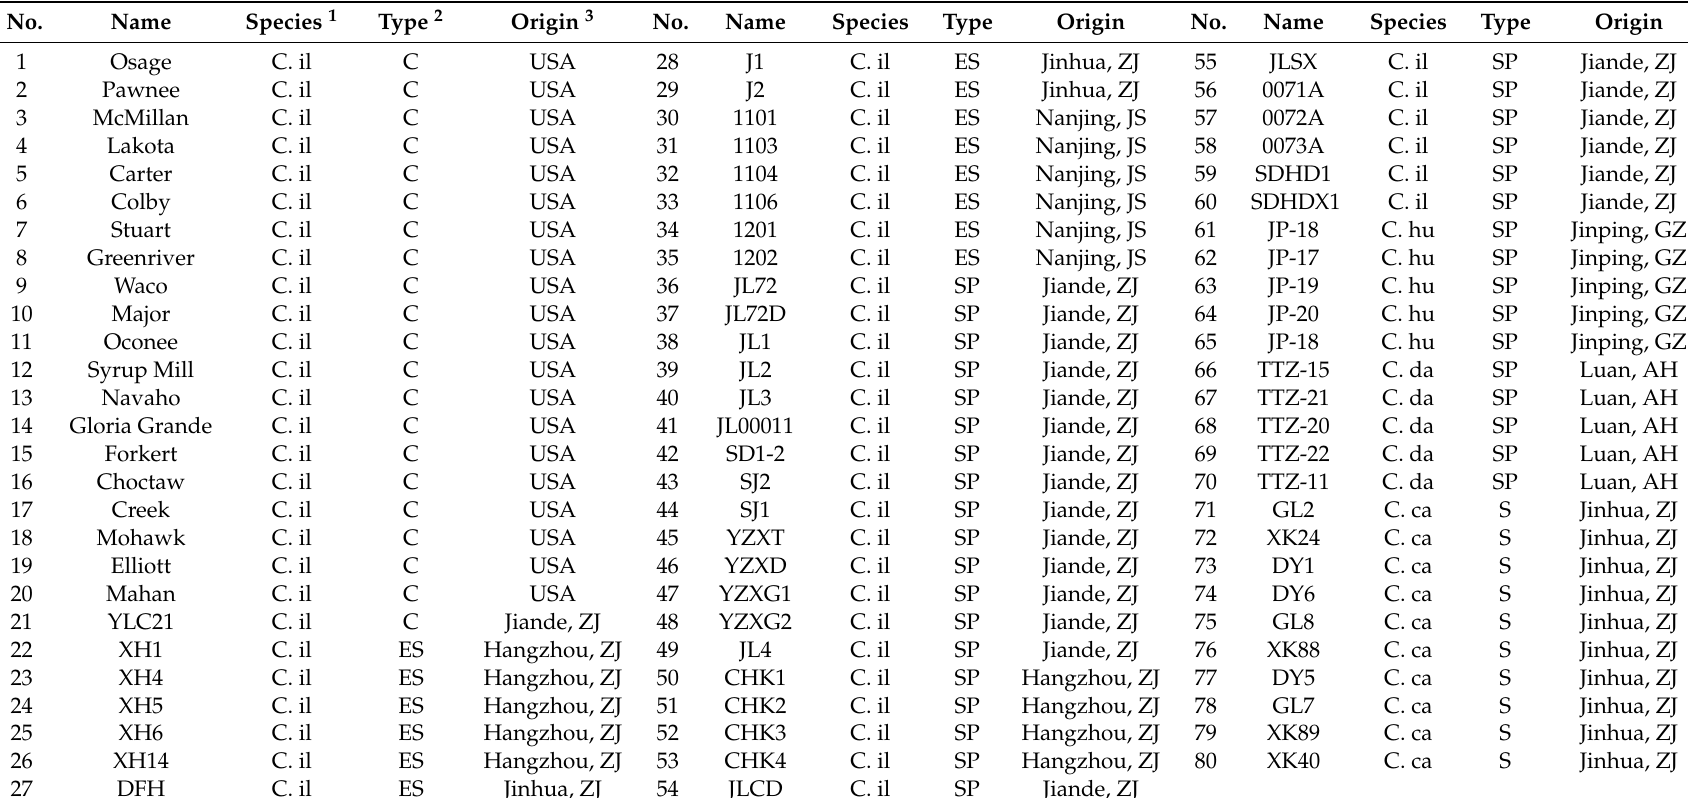
Table 1. The information about the plant